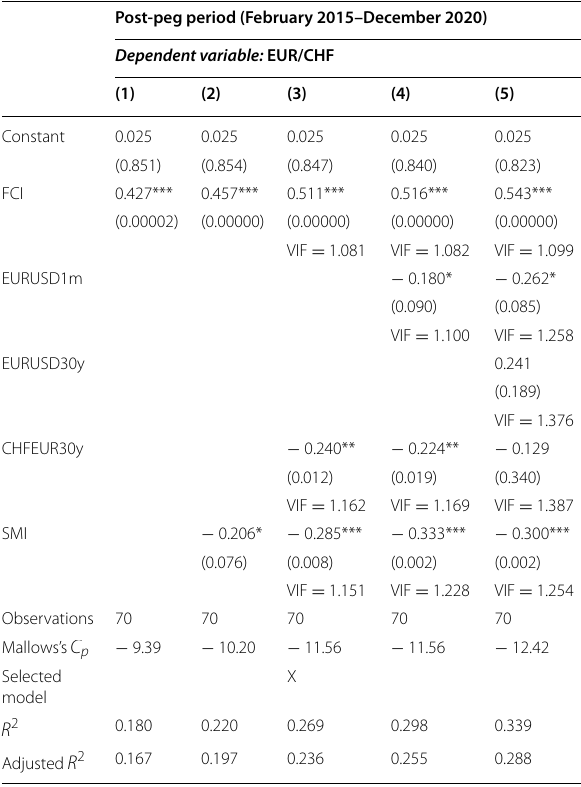
Table 6 OLS regression results for the post‑peg